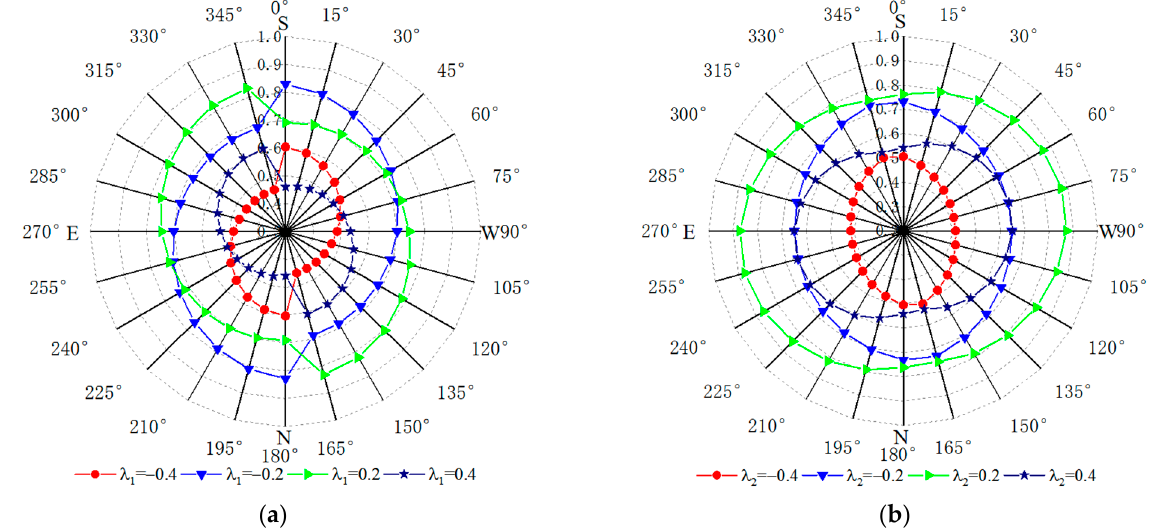
Figure 7. Variation of the effective tracking factor σ of an SDC system with different initial tracking positions under the azimuth axis tilt error. ( a ) The initial tracking position varies in the horizontal plane ( γ 2 = 0°). ( b ) The initial tracking position varies in the vertical plane ( γ 1 = 0°).